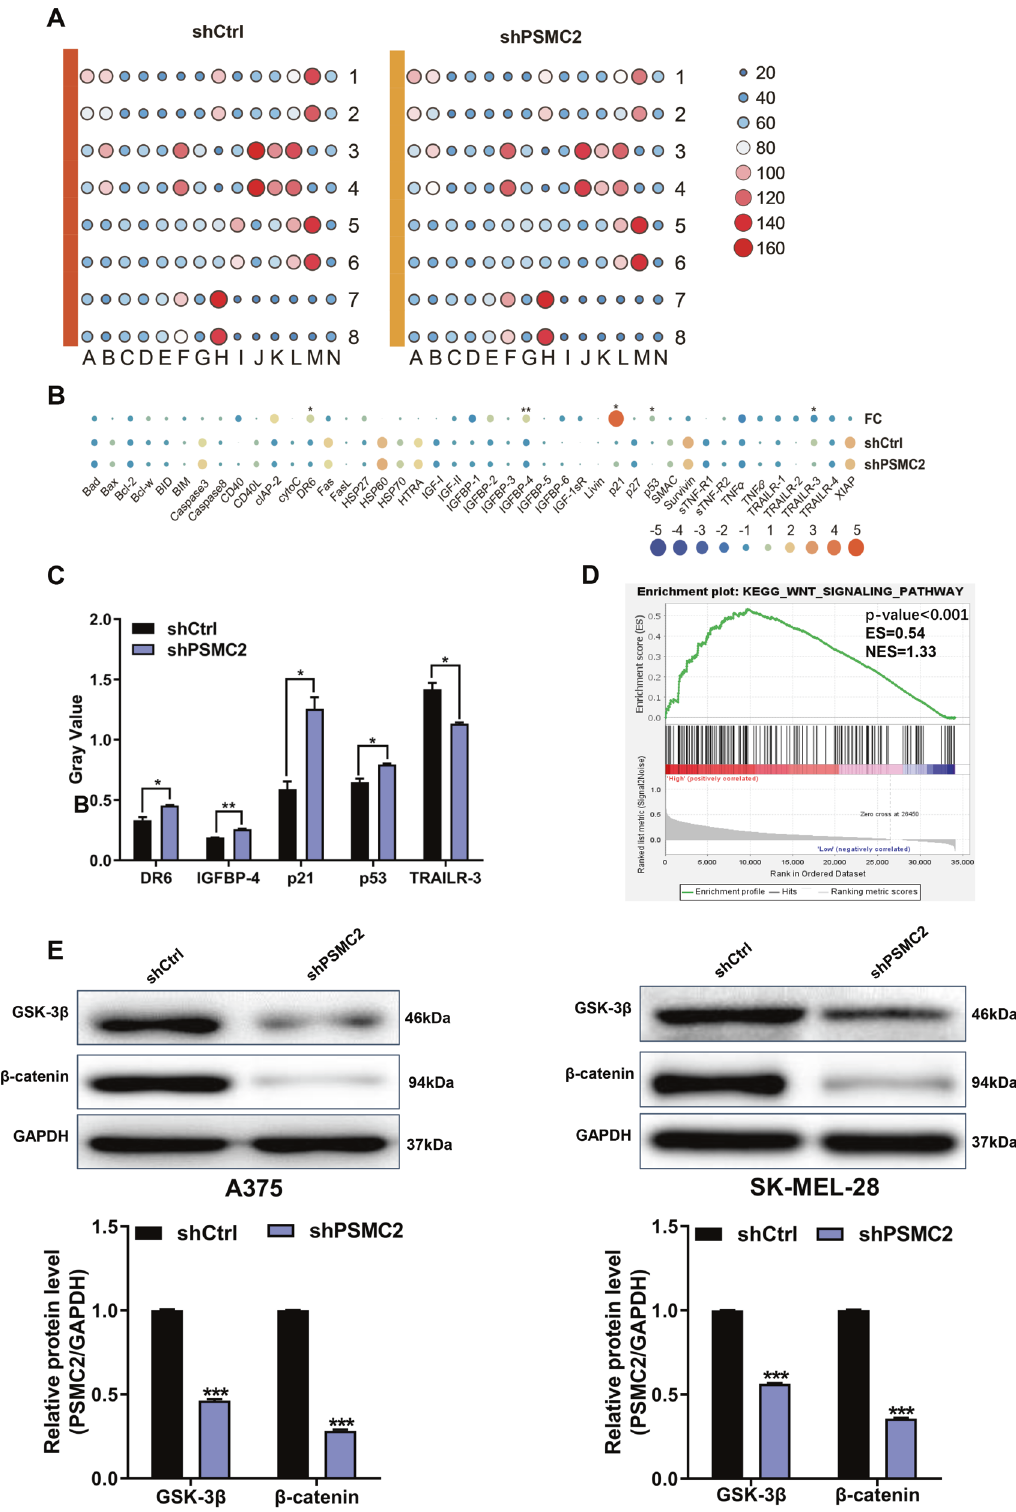
Fig. 6 Exploring the downstream regulatory mechanism and signaling pathway of PSMC2 in SKCM cells. A Human apoptosis antibody array was performed to analyze the differential expression of human apoptotic markers in SK-MEL-28 cells between shPSMC2 and shCtrl groups. B The relative protein levels of 43 human apoptotic markers in SK-MEL-28 cells between shPSMC2 and shCtrl groups. FC, fold change. C Gray value analysis for fi ve differential expression proteins (DR6, IGFBP-4, p21, p53, and TRAILR-3) in SK-MEL-28 cells between shPSMC2 and shCtrl groups. D Pathway enrichment gene sets of the Wnt signaling pathway in SKCM were shown in snapshoot of GSEA. E Western blot was used to detect the expression of GSK-3 β and β -catenin in A375 and SK-MEL-28 cells after shPSMC2 transfection. Each independent experiment was repeated at least three times. Data were presented as mean ± SD from three independent experiments. * p < 0.05, ** p < 0.01 and *** p < 0.001. Cell Death Discovery (2021)